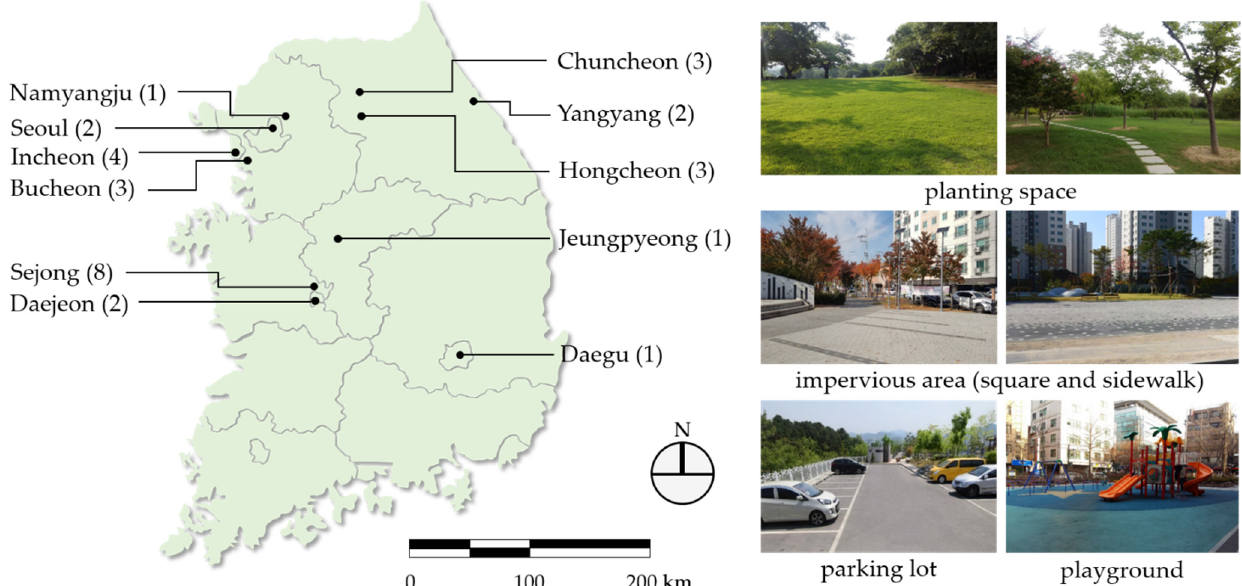
Figure 1. Location and landscape of study parks.